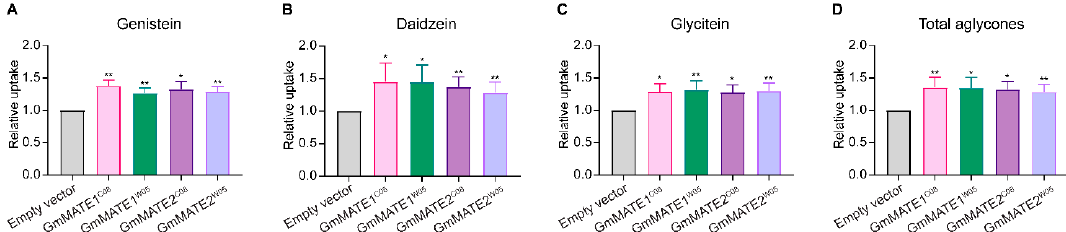
Figure 1. Yeast uptake assay using a mixture of genistein, daidzein, and glycitein. The level of ( A ) genistein, ( B ) daidzein, ( C ) glycitein, or ( D ) total aglycone (genistein, daidzein and glycitein) was determined. Metabolites were extracted from the yeast after feeding for 24 h and analyzed using UPLC against the respective standards. Values obtained from the yeast expressing GmMATE1 or GmMATE2 were normalized to those from the empty vector control (EV) in the same experiment. Values shown were the mean of six independent experiments ± SEM. Significant differences compared to EV were deter- mined by Mann-Whitney test. *, p < 0.05; **, p < 0.01. When the yeast constructs were fed with a mixture of isoflavone glycosides (genistin, daidzin, and glycitin), yeasts expressing GmMATE1 C08 or GmMATE1 W05 were able to accu- mulate more aglycones as well as more daidzin compared to the EV-transformed yeasts. Both aglycone and glycoside forms were detected in the metabolite extracts, probably due